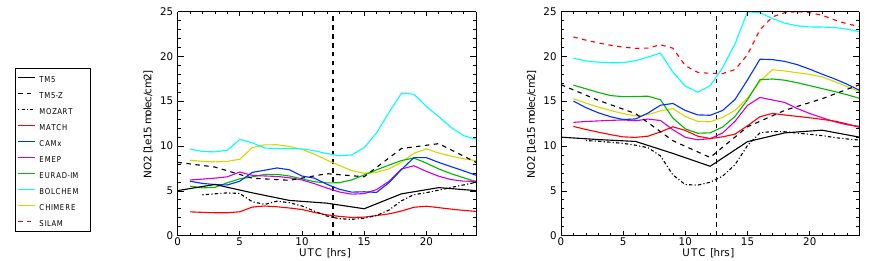
Fig. 11. Monthly average, diurnal cycle of NO 2 tropospheric columns in August (left) and December (right), over the Netherlands region. The dashed line indicates the OMI overpass-time.